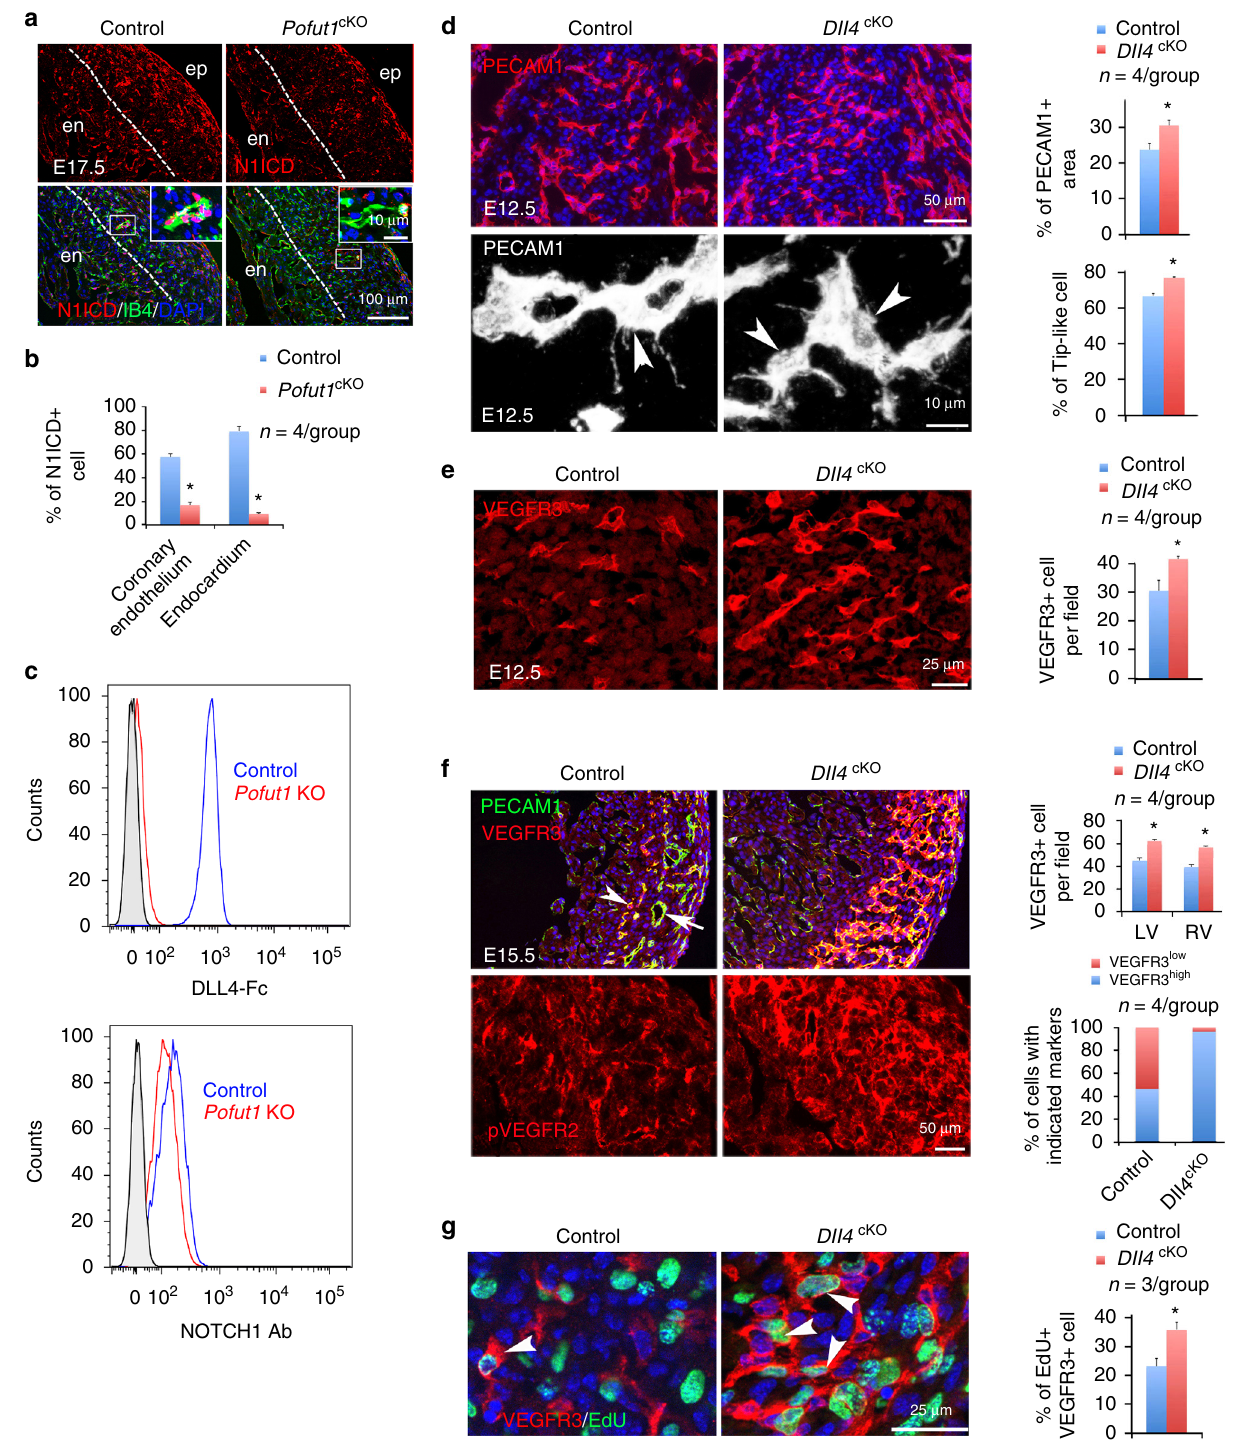
Fig. 4 POFUT1 regulates coronary artery formation via DLL4/NOTCH1 signaling. a , b Co-staining for N1ICD and IB4 showing reduced expression of N1ICD in coronary plexus of E17.5 Pofut1 cKO heart. Dotted line separates trabeculae from compact myocardium. c DLL4-Fc binding and NOTCH1 extracellular domain antibody binding to control ( blue pro fi les) and Pofut1 knockout ( Pofut1 KO) ( red pro fi les) CHO cells showing reduced DLL4 binding by Pofut1 KO cells, which have normal NOTCH1 expression. Grey pro fi les re fl ect secondary antibody alone. d , e PECAM1 and VEGFR3 staining for coronary angiogenic cells ( arrowhead ) in coronary plexuses at E12.5, one-day after Dll4 deletion, showing increased PECAM1+ area, the number of PECAM1+ tip-like or VEGFR3 + cells in Dll4 cKO ( Dll4f /f ;Cdh5 CreERT2 ). f PECAM1 and VEGFR3 staining for coronary angiogenic cells ( arrowhead ) and arteries ( arrow ) at E15.5, one-day after Dll4 deletion, shows increased number of VEGFR3 high cells in Dll4 cKO . * p < 0.001. g EdU labeling of VEGFR3+ coronary angiogenic cells at E15.5, 1 day after Dll4 deletion, shows increased proliferation of VEGFR3 cells ( arrowheads ). All bar charts represent mean ± SD; * p < 0.001. en/ep,